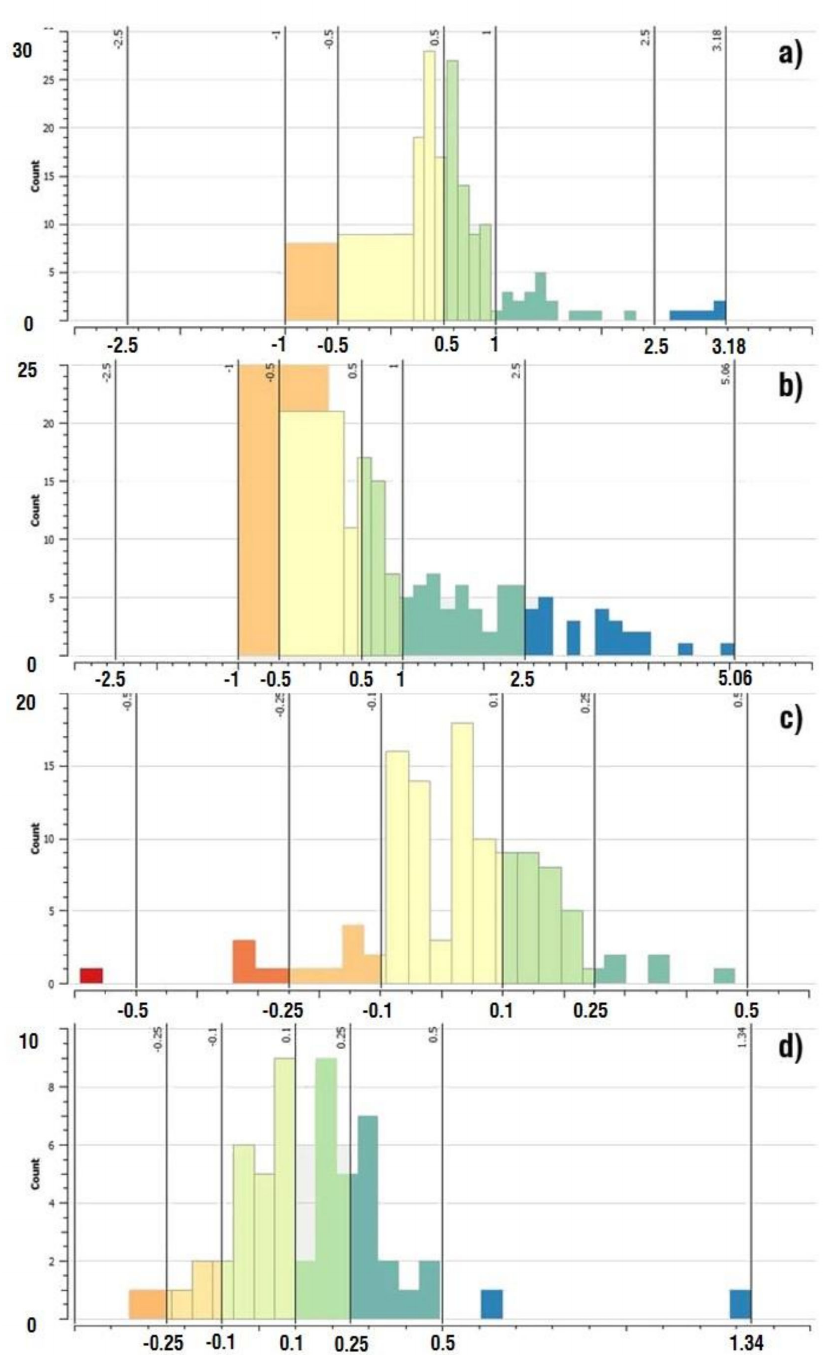
Figure 10. DSAS EPR analysis histograms: ( a ) DFL; ( b ) SVL; ( c ) DCL; ( d )